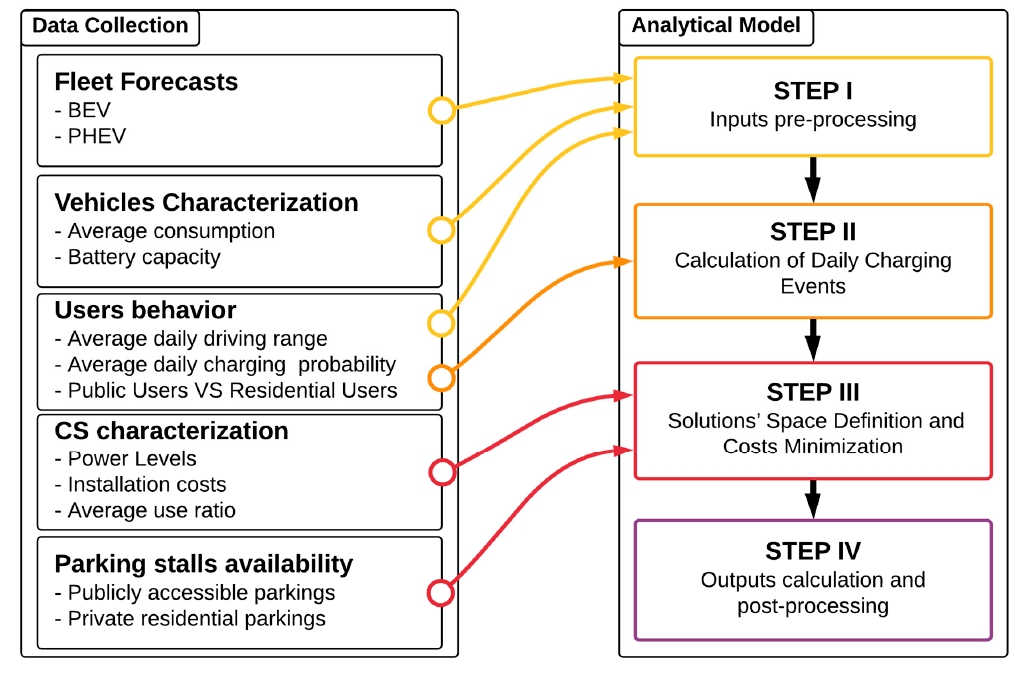
Figure 1. High-level visual description of the model structure.